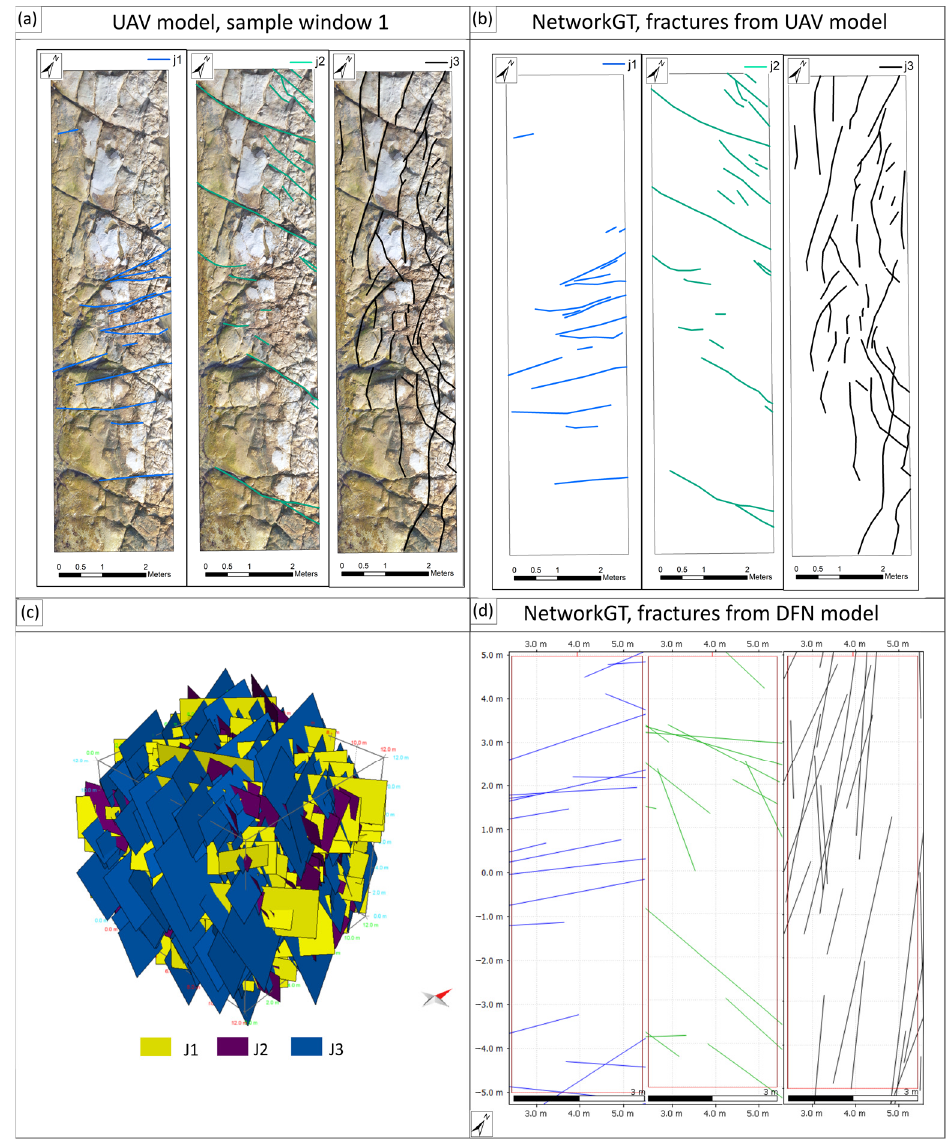
Figure 5. Fracture analysis results performed in NetworkGT for fracture set J1, J2, and J3 of sampling